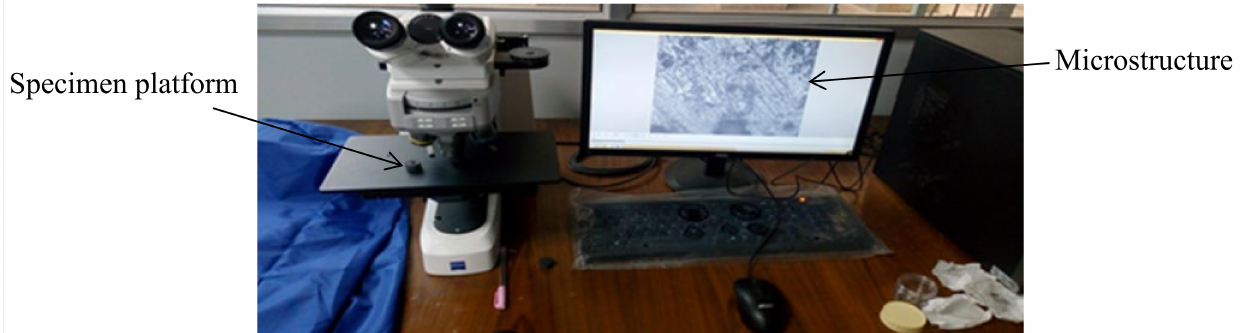
Figure 12. Optical